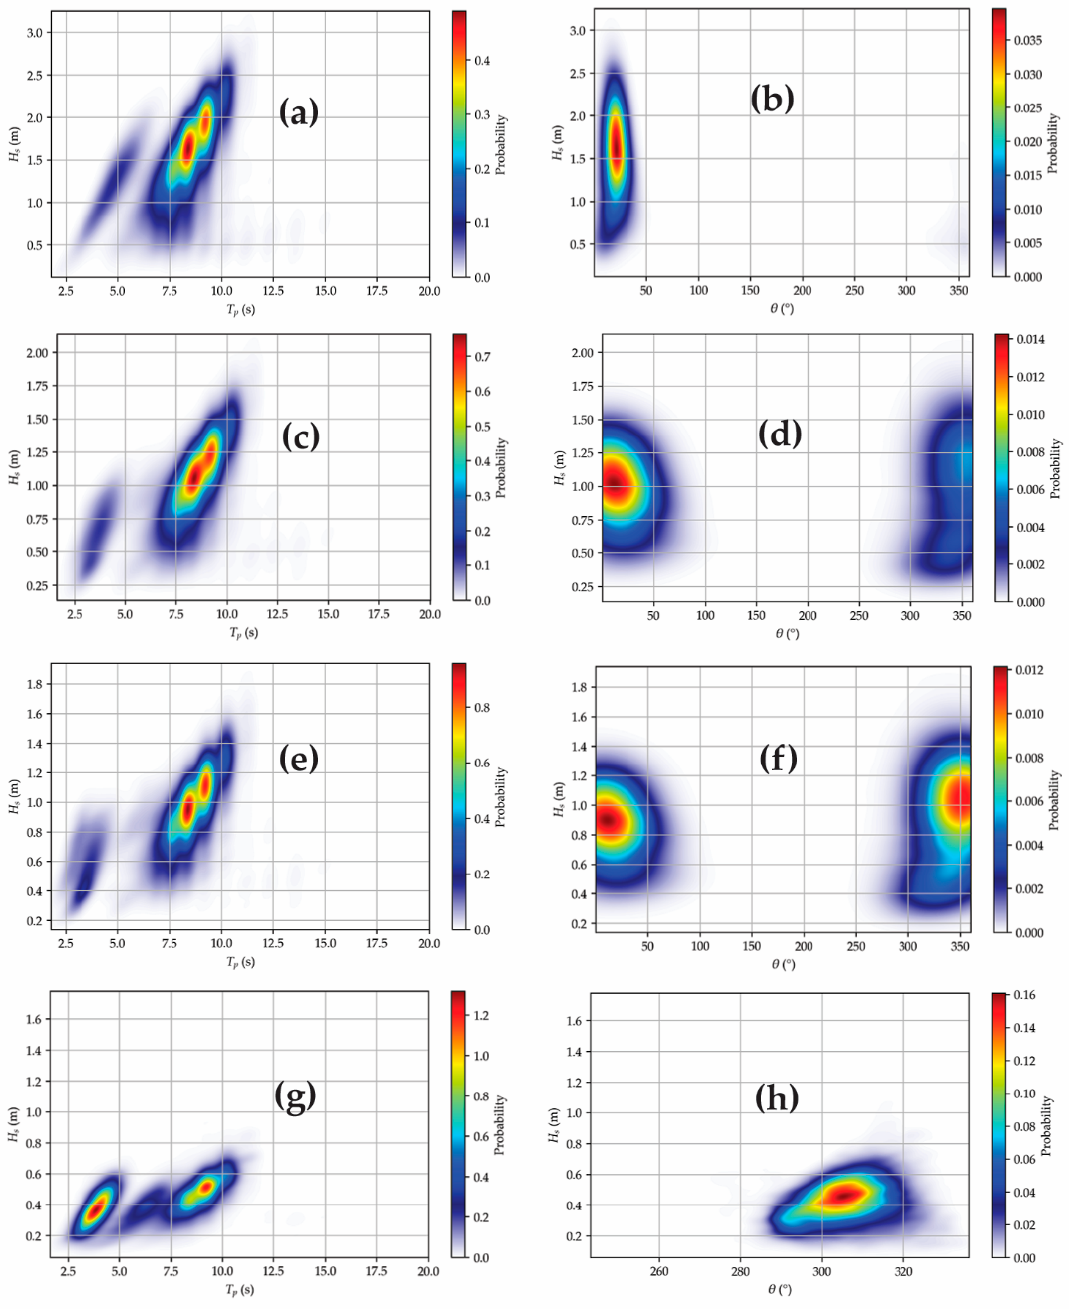
Figure 6. Joint probability distributions of significant wave height, peak period, and mean direction at Km 19 ( a , b ), Tasajera ( c , d ), Pueblo Viejo ( e , f ), and Ciénaga ( g , h ).